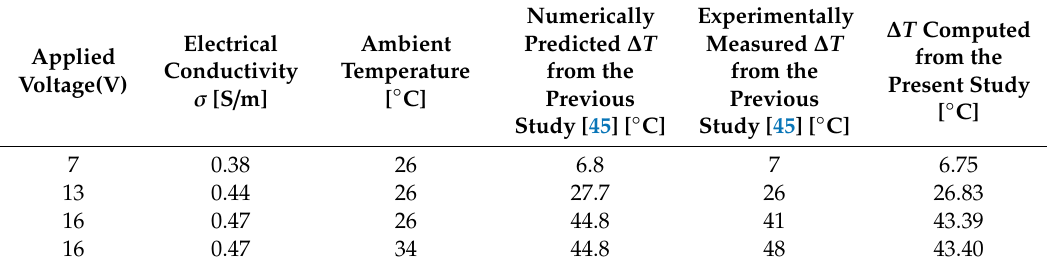
Figure 3. Temperature distribution (in ◦ C) along with lateral ( W ) and longitudinal ( L ) dimensions of the ablation zone obtained after 60 s of continuous RF procedure with the applied voltage of 13 V and an ambient temperature of 37 ◦ C. Table 2. Comparison of the rise in temperature ( ∆ T ) reported by Cosman Jr. and Cosman Sr. [45] in terms of both numerical and experimental findings to that computed from the present model after 120 s of the continuous RF procedure.